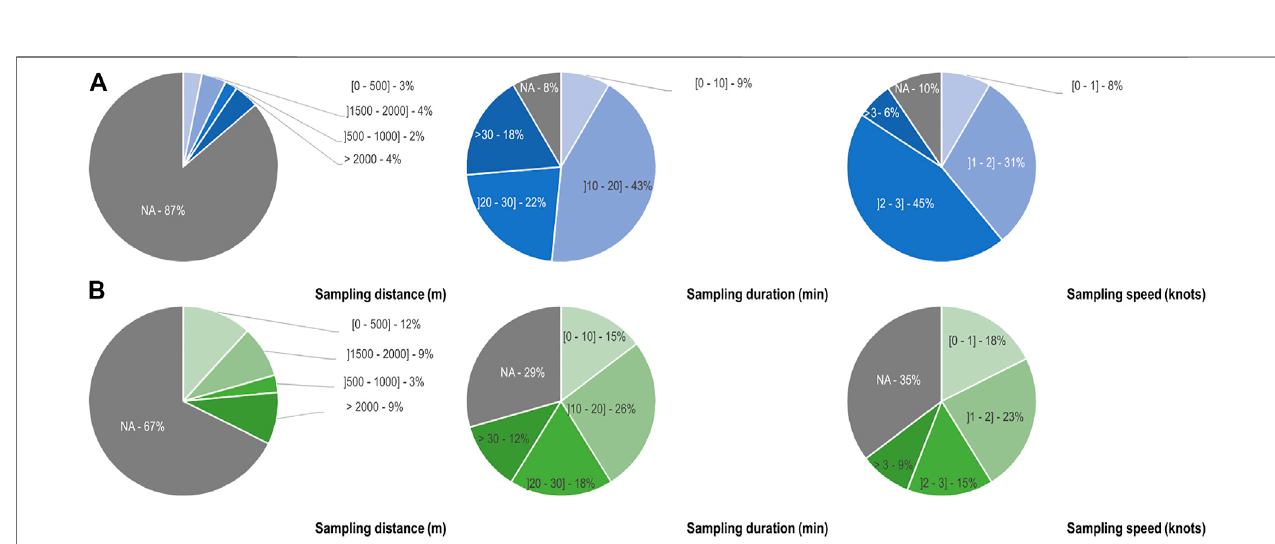
FIGURE 5 | Dispersion of sampling distance, sampling duration and sampling speed of the reviewed literature including studies made in seawater (A) and freshwater (B) .